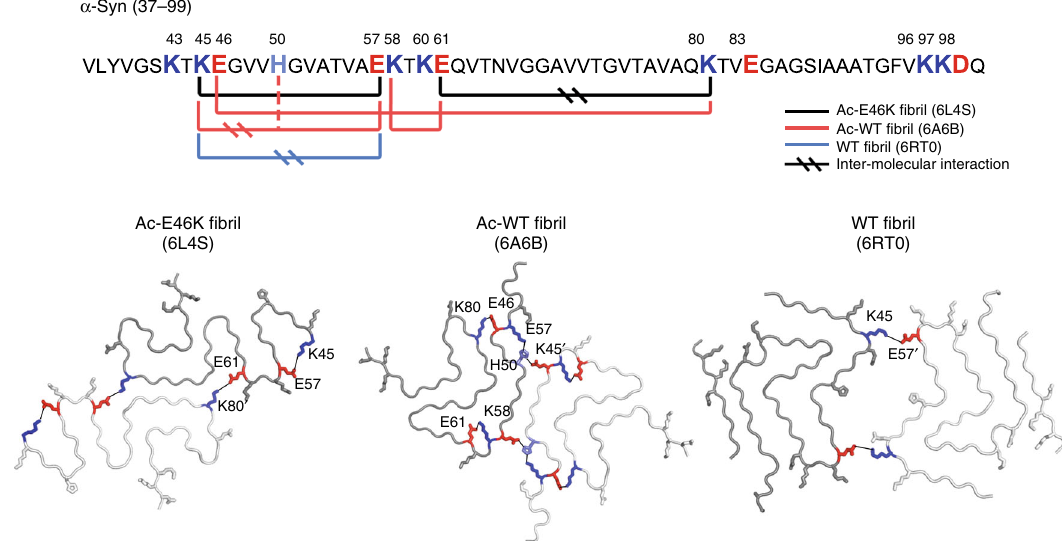
Fig. 5 Electrostatic interactions in α -syn fi bril polymorphs. Primary sequence of WT α -syn fi bril core (FC) is shown on top. K residues are colored in blue; H is light blue; E/D is red. Interacting charged residues in the structures of different α -syn polymorphic fi brils are connected with solid lines. One layer of different polymorphic structures of α -syn fi brils are shown below. The dimeric α -syn molecules are colored in different levels of gray. Electrostatic interactions are highlighted with K colored in blue, H in light blue and E in red. PDB IDs of the structures are provided in